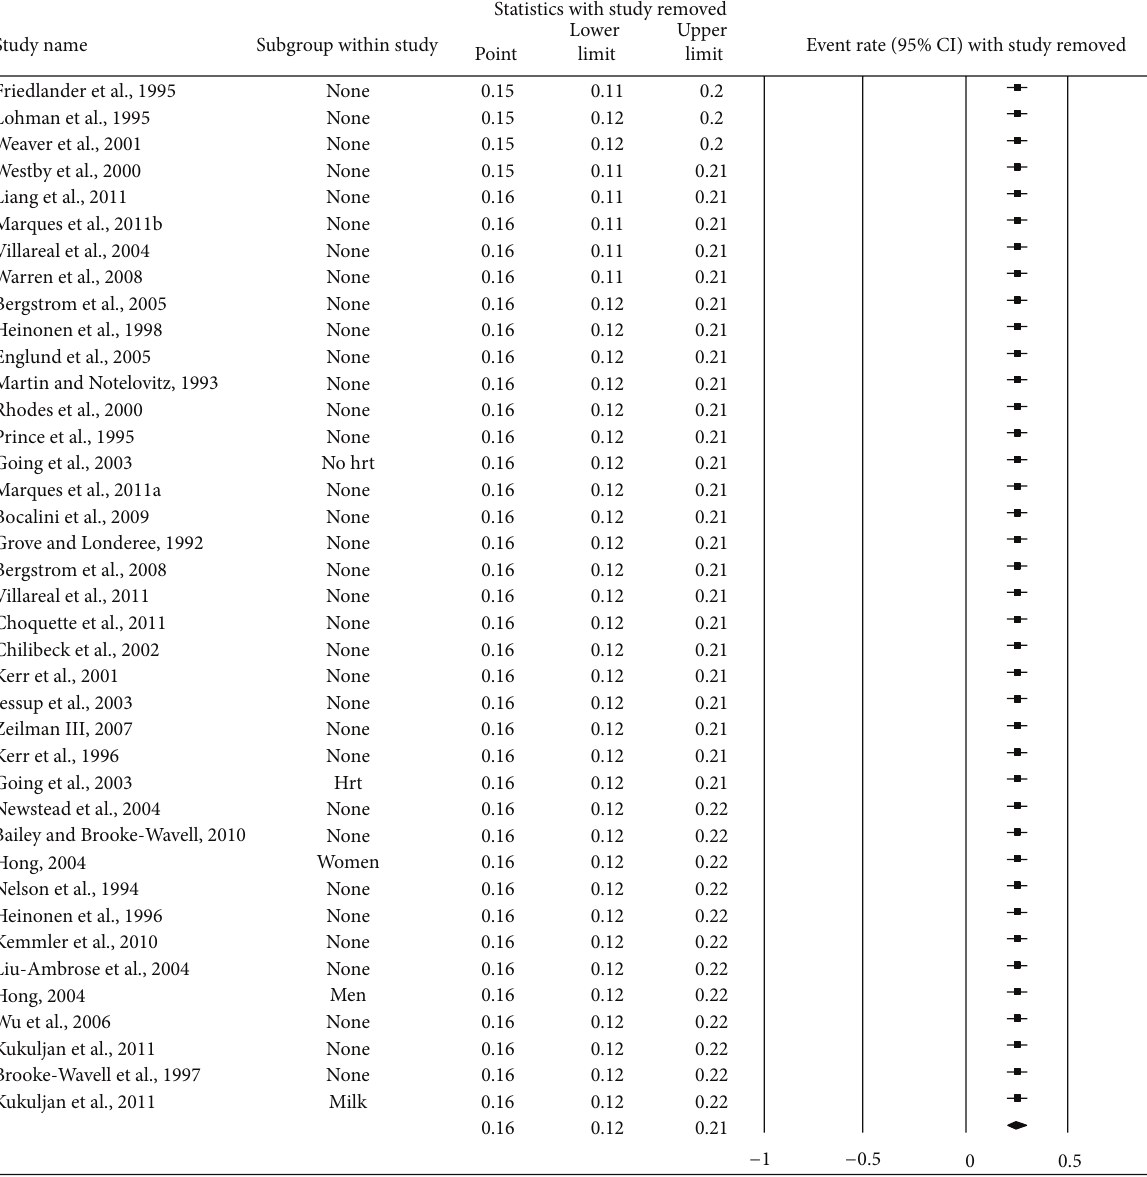
Figure 7: Influence analysis for control dropouts. Influence analysis for control group dropouts with each group deleted from the model once. The black squares represent the event rate while the left and right extremes of the squares represent the corresponding 95% confidence intervals. The middle of the black diamond represents the overall event rate while the left and right extremes of the diamond represent the corresponding 95% confidence intervals. Results are ordered from the smallest to the largest values.